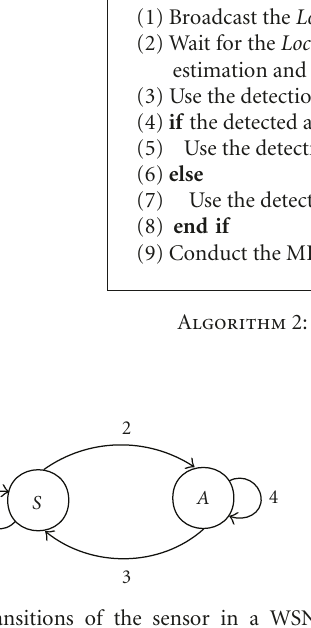
Figure 2: State transitions of the sensor in a WSN under the distance-consistent spoofing attack. S and A denote the safe state and attacked state,